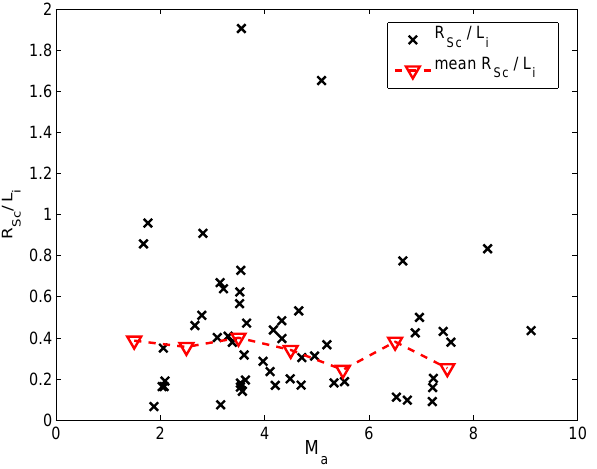
Fig. 3. The normalised shock ramp spatial scales plotted against Alfv ´ en Mach number. The black markers show the individual cross- ings whereas the red dashed line shows the mean values for Mach numbers between (1–2, 3–4, 4–5 etc.). The means do not take into account the two outliers around 1.6 and 1.8.